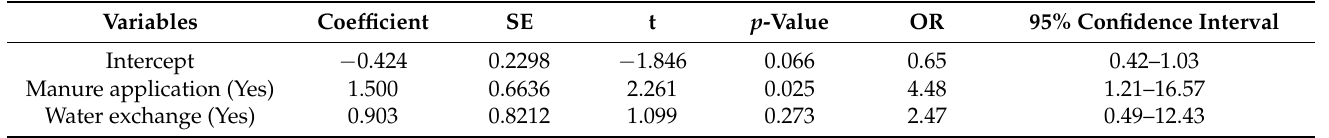
Table 2. Multilevel binary logistic regression of risk factors associated with the occurrence of MDR E. coli in the aquaculture production system ( n = 32) on the west coast of peninsular Malaysia.